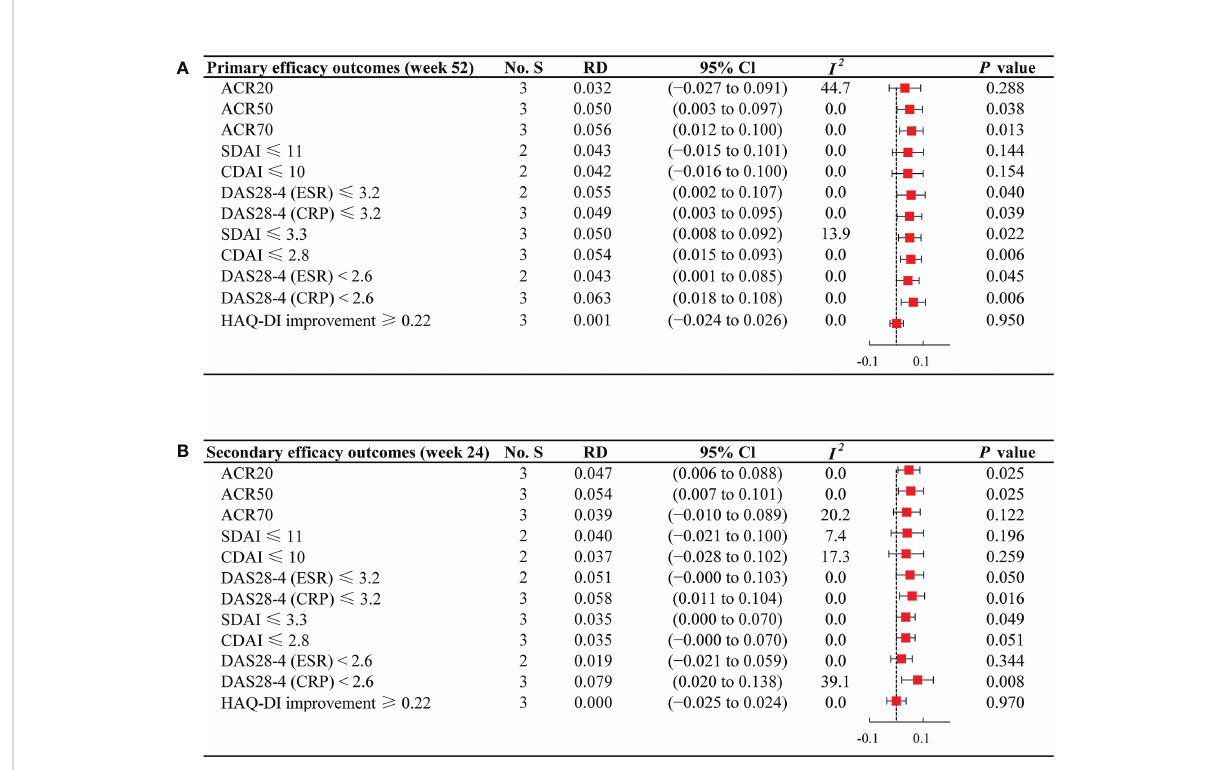
(Supplementary Table 3). For ACR50 and ACR70, patients